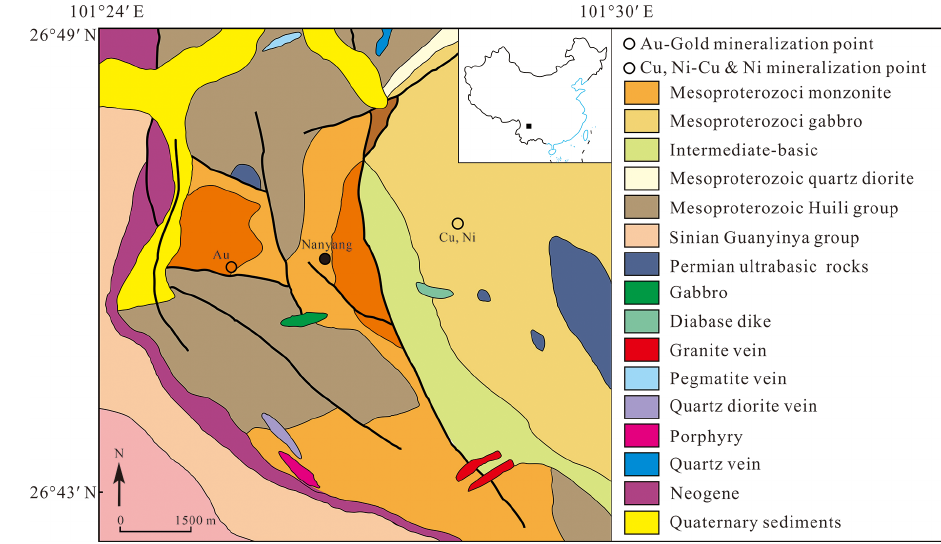
https://doi.org/10.5194/ejm-34-95-2022 Eur. J. Mineral., 34, 95–108,